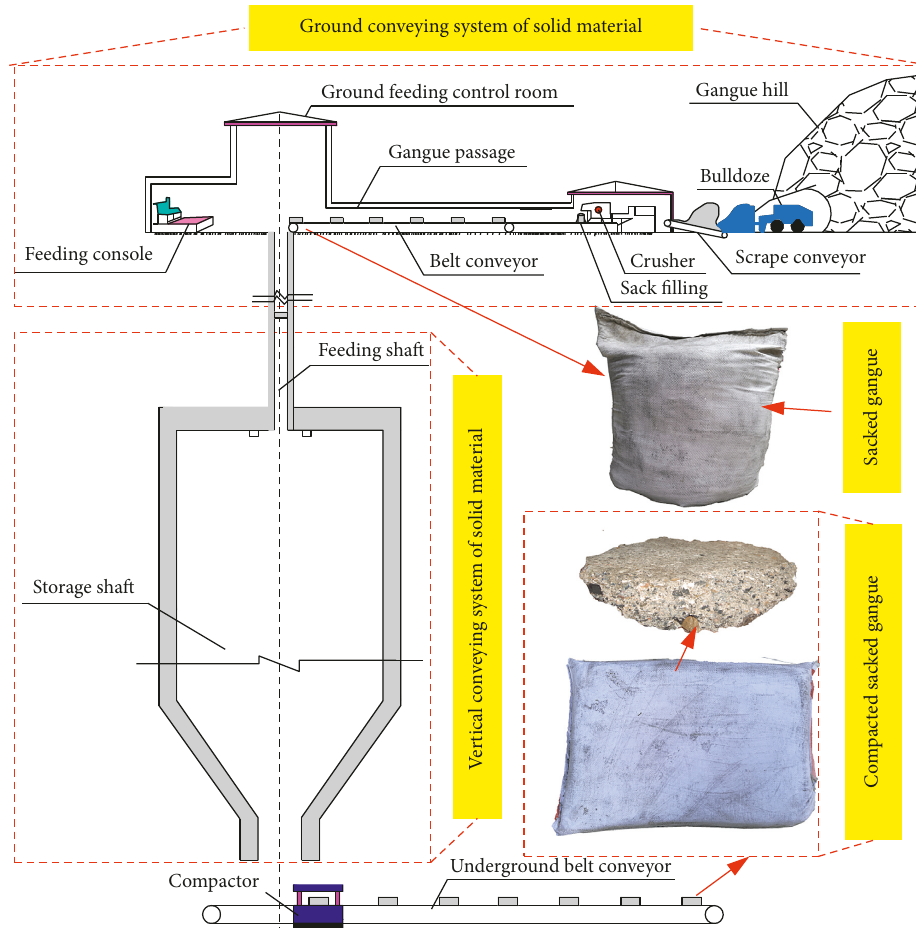
Figure 2: The vertical transportation system of roadside support body material.